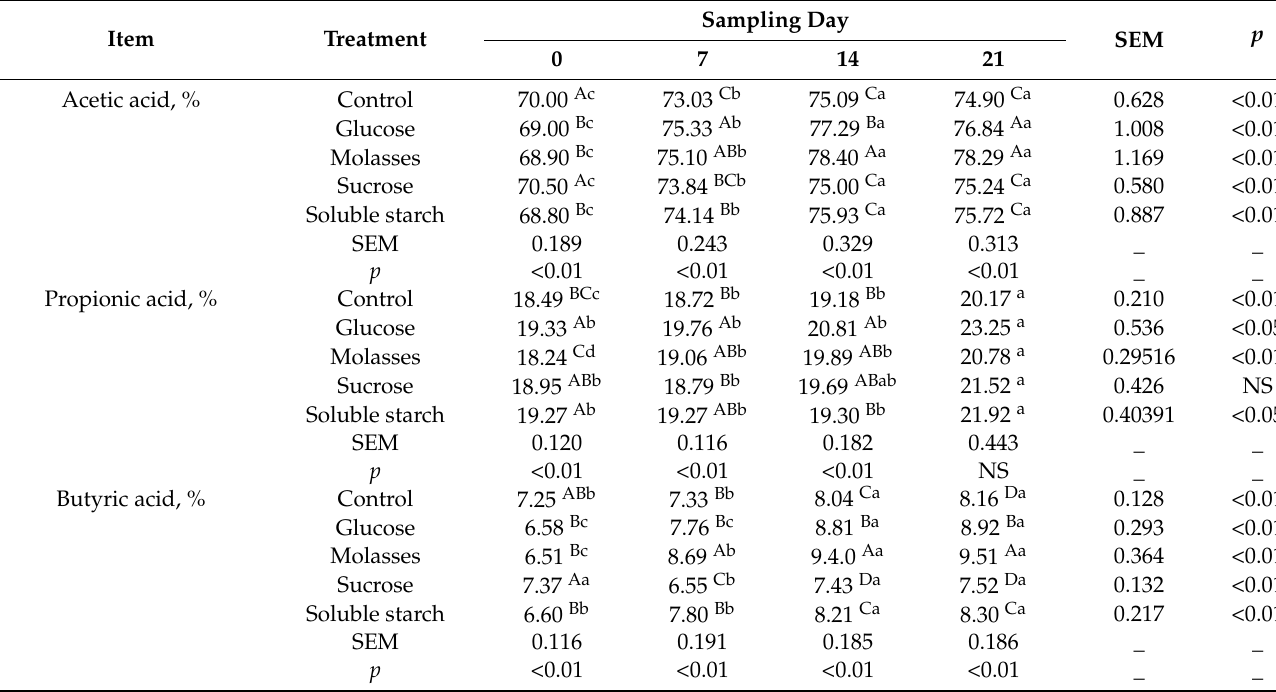
Table 7. Proportion of volatile acids in corn